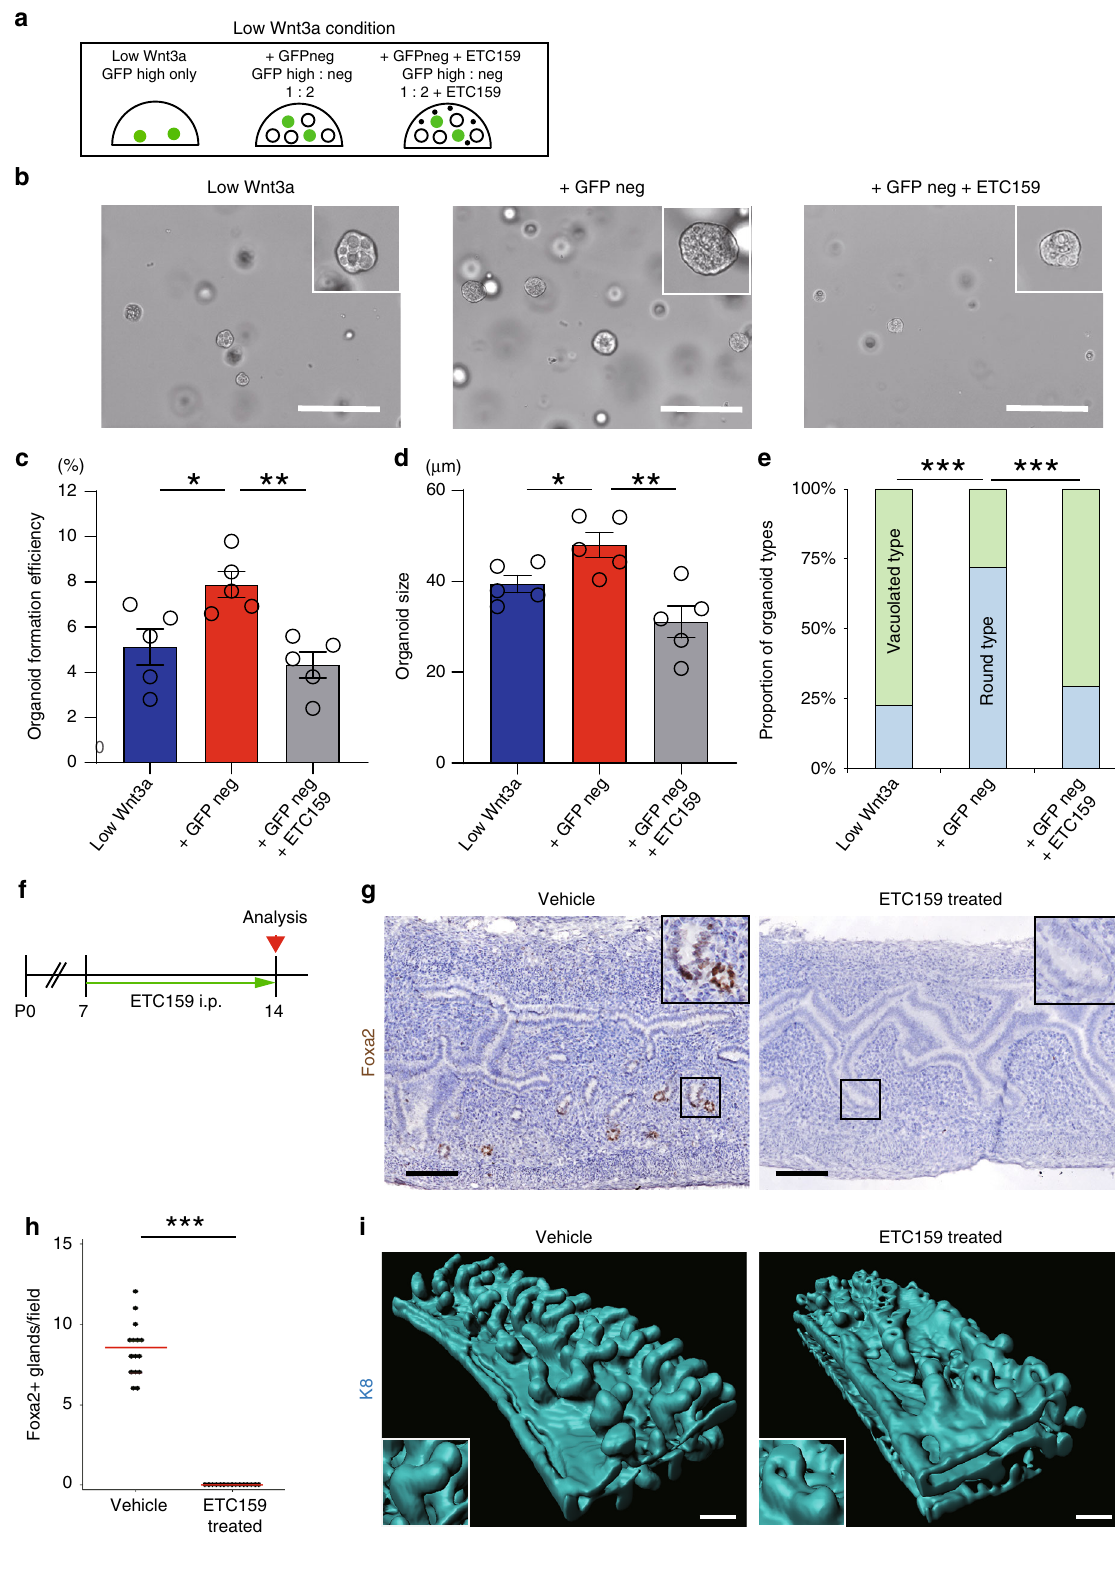
and stained in an Affymetrix Fluidics Station 450, and hybridized probe fl uores- cence was detected using the Affymetrix G3000 GeneArray Scanner. CEL fi les were generated for each array and used for gene expression analysis. The CEL fi les were then processed in R (v3.6.0) with the Bioconductor (v3.9) libraries oligo (v1.48.0), mogene20sttranscriptcluster.db (v8.7.0), and limma (v3.40.2). We used robust multi-array average (RMA) 46 to perform background correction and normalization